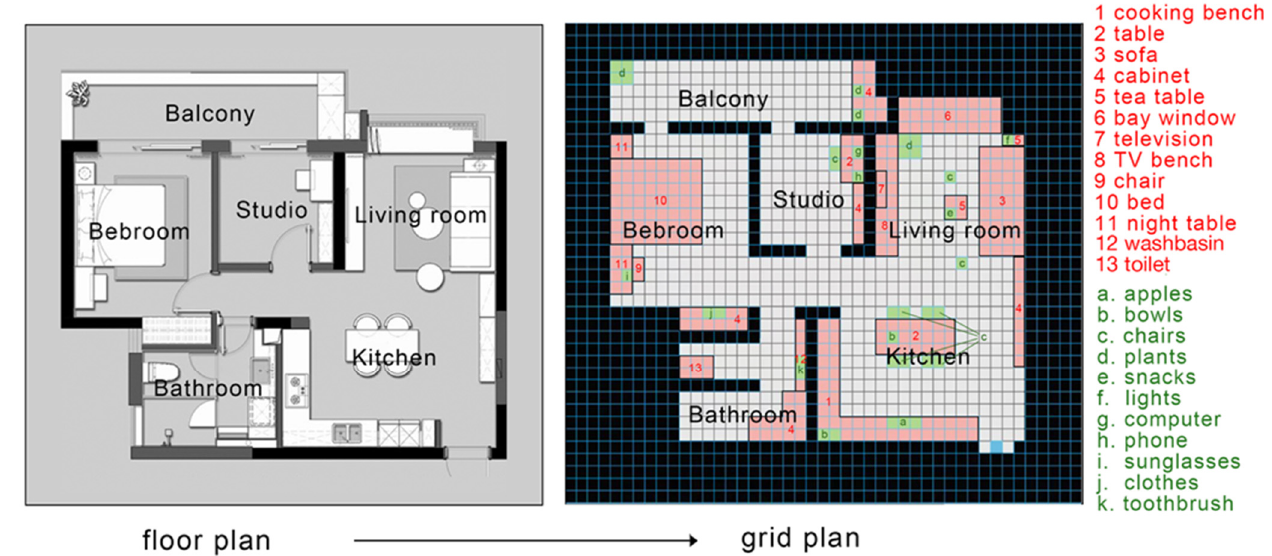
Figure 3. A partition from house plan to grid